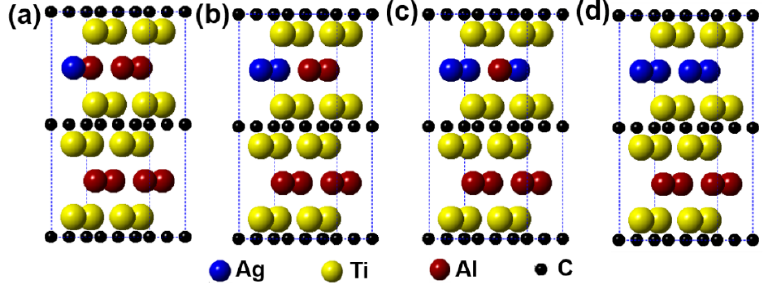
Figure 2. Models of the Ti 2 (Al 1 − x ,Ag x )C supercells with different substitution ratios of Ag for Al: ( a ) Ti 2 (Al 0.875 ,Ag 0.125 )C; ( b ) Ti 2 (Al 0.75 ,Ag 0.25 )C; ( c ) Ti 2 (Al 0.625 ,Ag 0.375 )C; ( d ) Ti 2 (Al 0.5 ,Ag 0.5 )C.